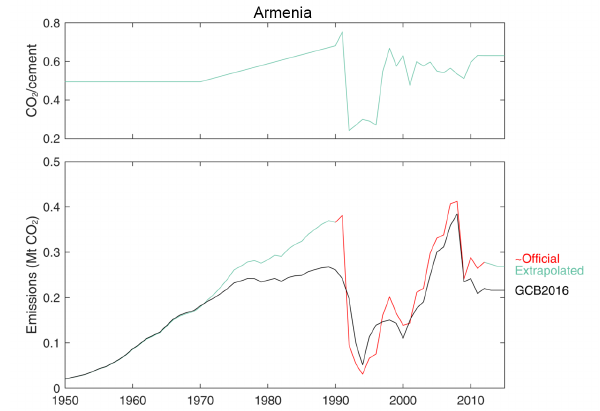
Figure C9. Revised cement emissions for Armenia.